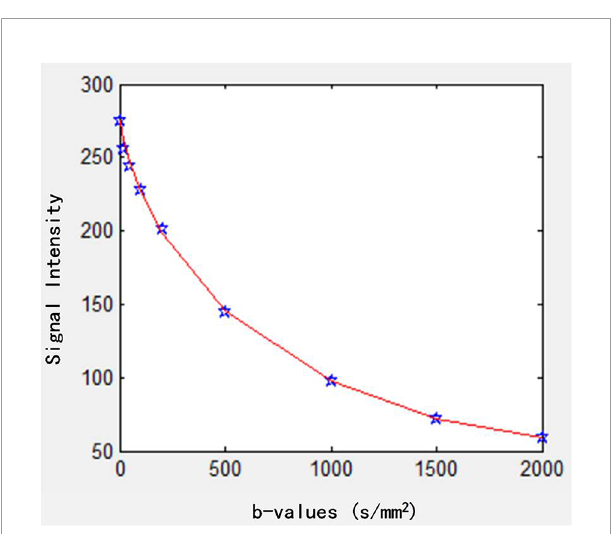
FIGURE 2 | Fitting curve of the IVIM-kurtosis model. IVIM, intravoxel incoherent motion.